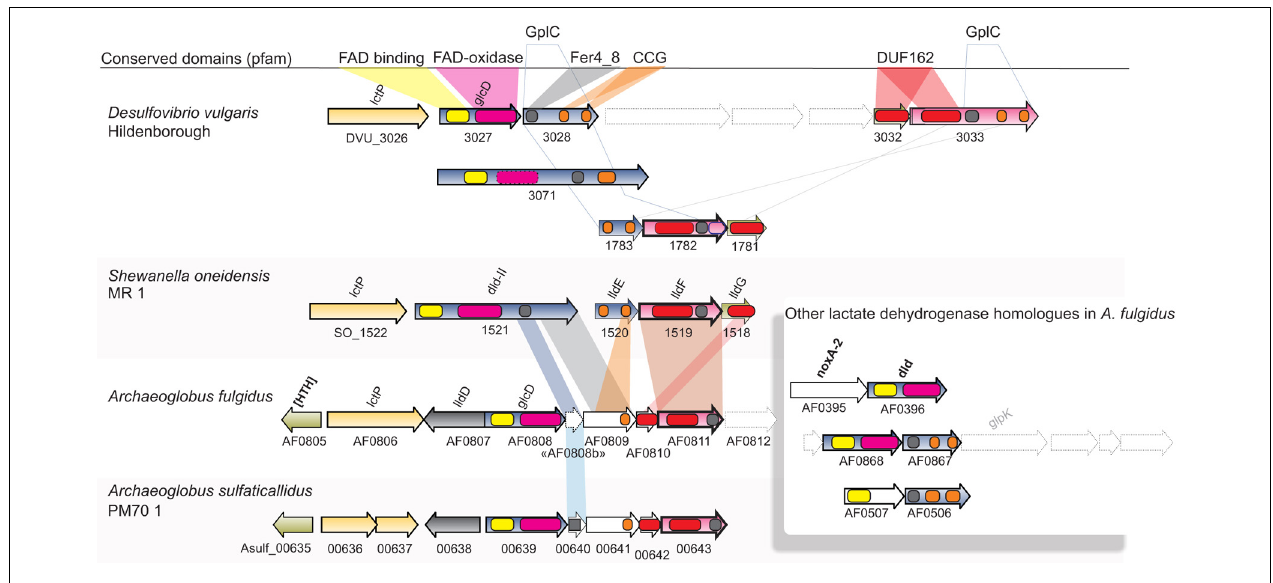
FIGURE 3 | Synteny and domain composition between lactate dehydrogenases and associated genes. The genes of A. fulgidus correspond to a lactate dehydrogenase (lldEFG), D -lactate dehydrogenase (dld/dld-II), and lactate permease (lctP) which are found co-located in a wide